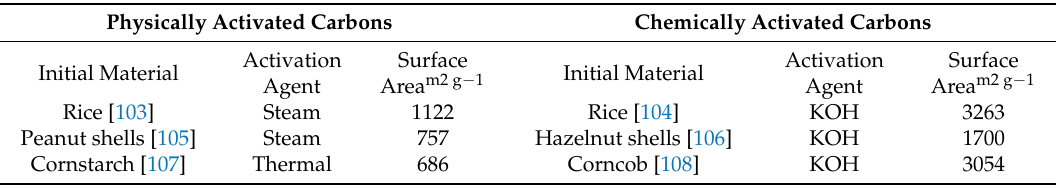
Table 6. Surface area values for physically and chemically activated carbons obtained from different